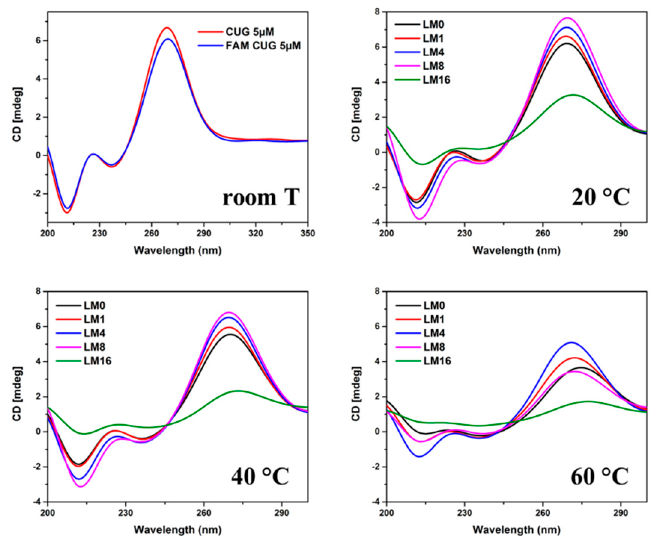
Figure 7. CD spectra of native r(CUG) 10 as control at room temperature and FM1 r(CUG) 10 as targeted RNA template for sisomicin titration at 20–60 ◦ C. All annealed RNA samples were prepared at 5 µ M with a volume size of 200 µ L; sisomicin to RNA molar ratios of 0, 1, 4, 8, and 16; native r(CUG) 10 CD spectrum from 350–200 nm and FM1 r(CUG) 10 RNA–sisomicin CD spectra from 300– 200 nm.